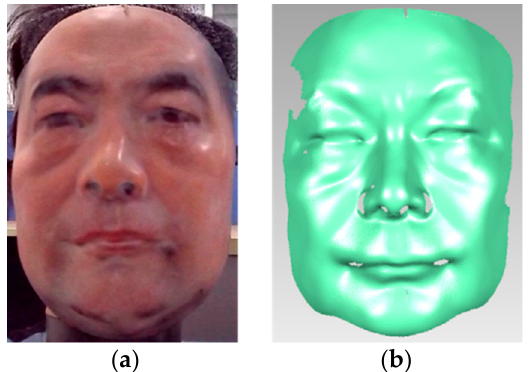
Figure 6. ( a ) A plastic human face mask; ( b ) Its ground truth obtained by ATOS Core 300.